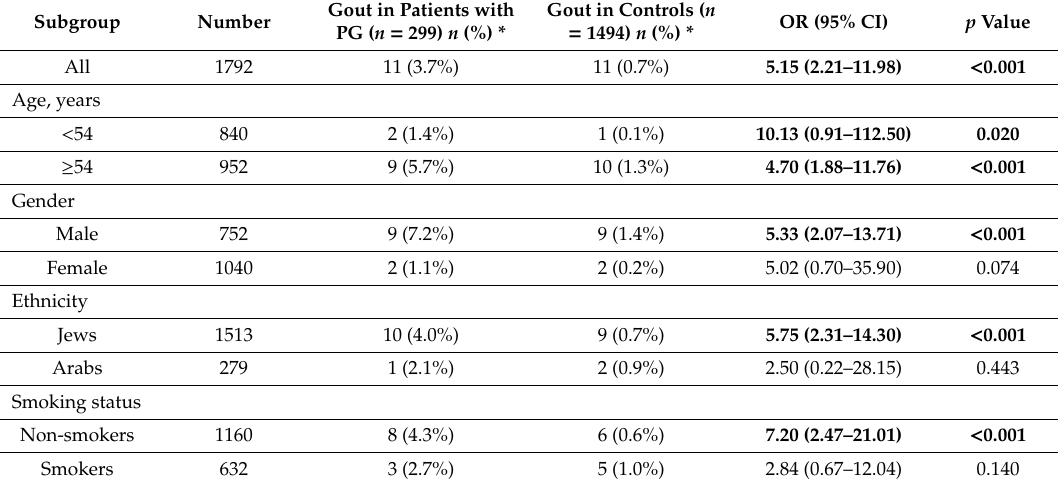
Table 2. The risk of pyoderma gangrenosum (PG) in patients with a preceding diagnosis of gout stratified by age, sex, and ethnicity (a case-control